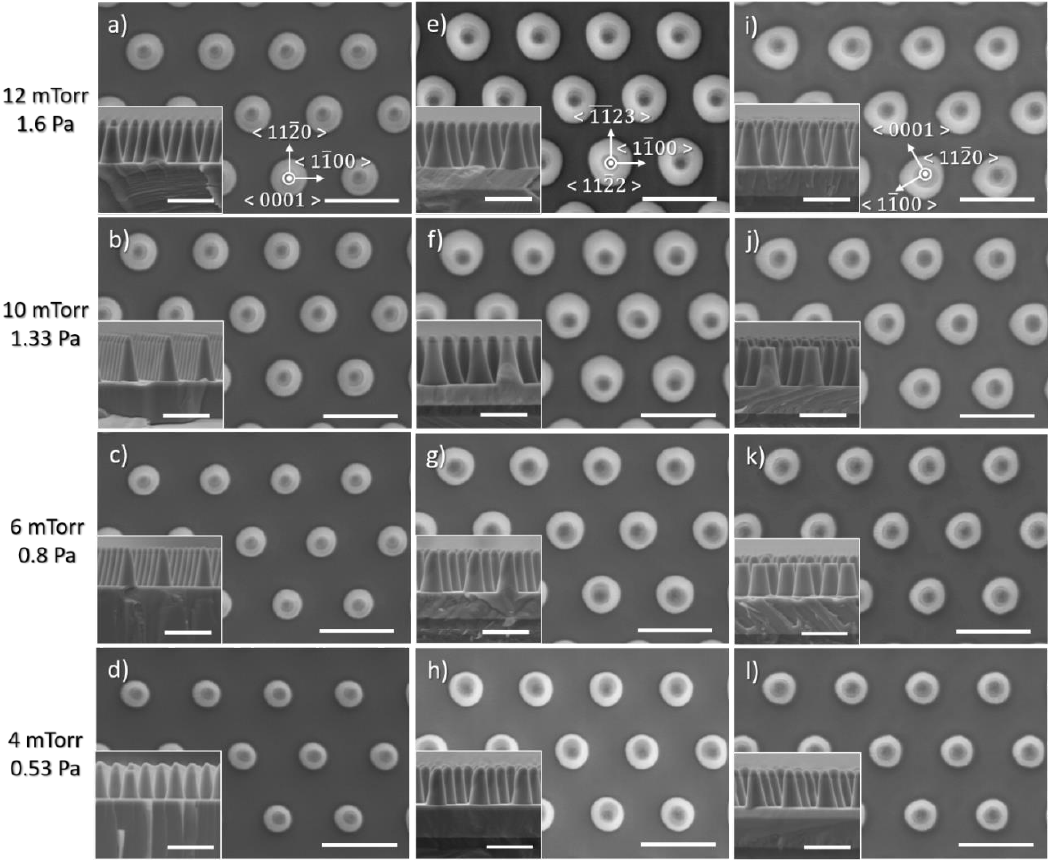
Figure 4. Plan view and cross-sectional (inset) SEM image of GaN nanorod etch series 2 under different chamber pressures for ( a – d ) c -plane ( e – h ) (11 2̅2 ) semi-polar and ( i – l ) ( 112̅0 ) non-polar GaN layers. Scale bar is 1 µm.